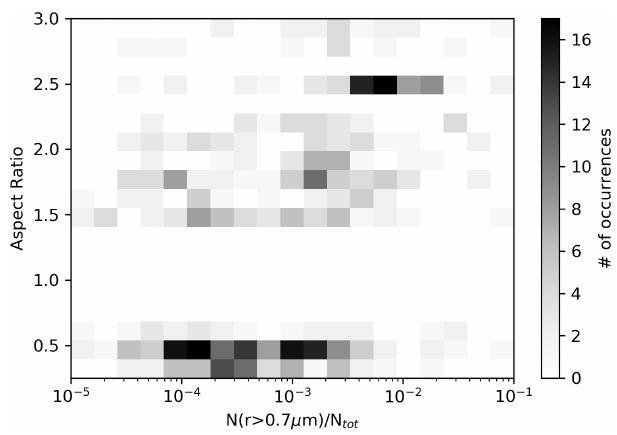
Figure 6. A 2D histogram of occurrence of ARs and of N(r > 0 . 7µm )/N tot , the ratio between particles with radius greater than 0.7µm and total particles. Only ARs in the intervals between 0.3 and 0.55 and between 1.5 and 3 have been considered.